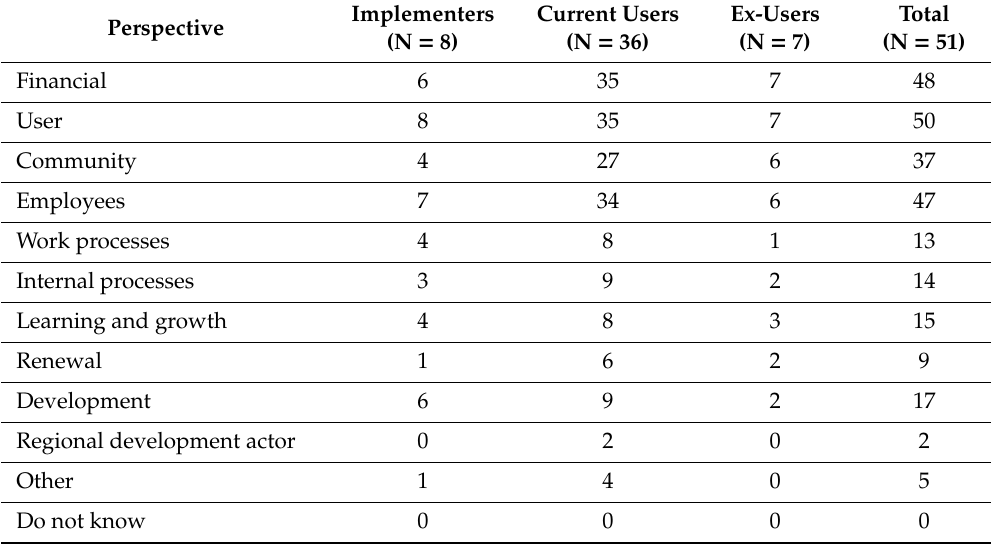
Table 8. BSC perspectives used (N =